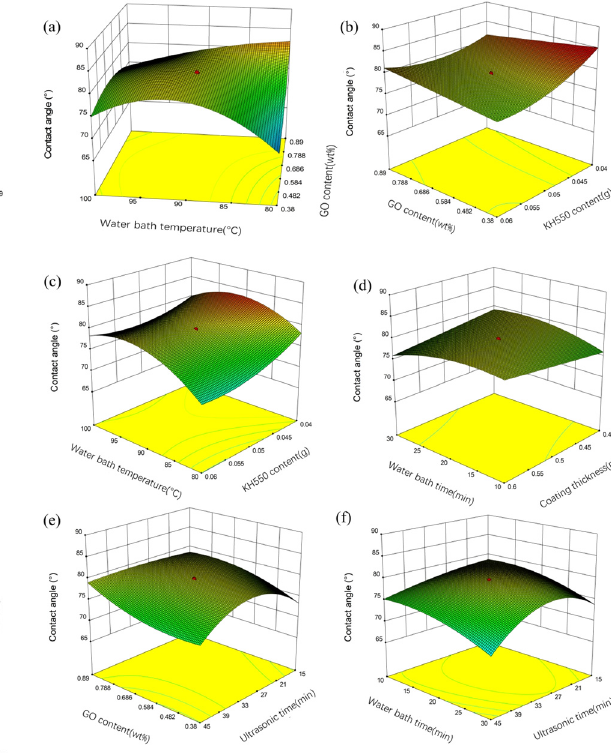
Figure 8: Response surface plots ( a ) – ( f ) showing interaction e ff ects of contact